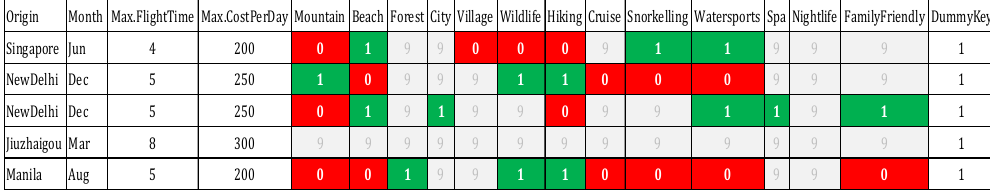
Figure 22. Summary of an integrated data view of the augmented big data analytics model.